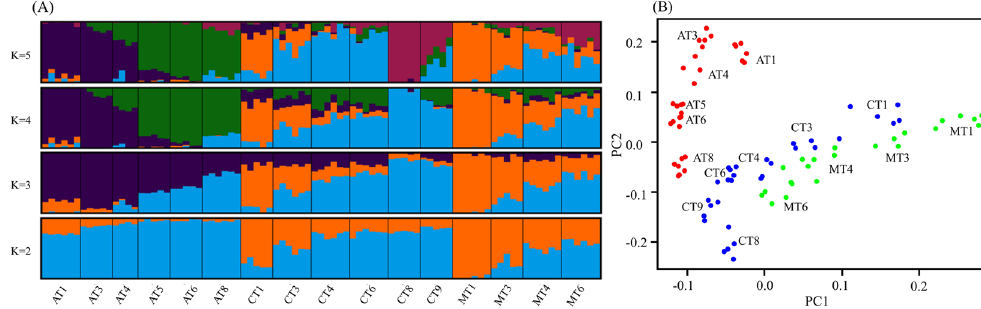
Figure 2. Population structure of A. m. iberiensis . ( A ) Structure estimated by sNMF from K = 2 to K = 5. The 16 sampling sites are arranged from north (AT1, CT1, MT1) to south (AT8, CT9, MT6) in each of the three transects. Plots represent each of the 87 individuals by a vertical bar partitioned into coloured segments (clusters) corresponding to membership proportions (Y-axis: 0-1) in each cluster. Vertical black lines separate the 16 sampling sites. ( B ) Score plot displaying the latent factors of each individual honeybee in PC1 and PC2 for K = 2. Each colour represents a different